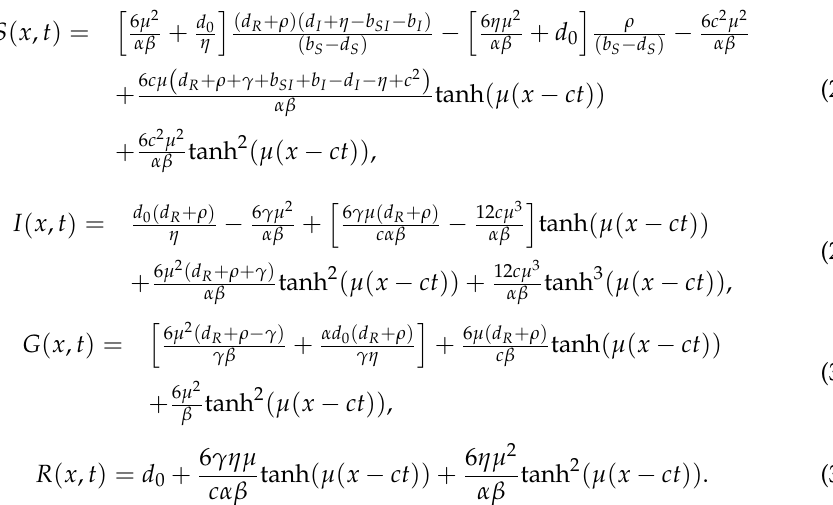
Thus, the exact solution of the model system can be written as follows: